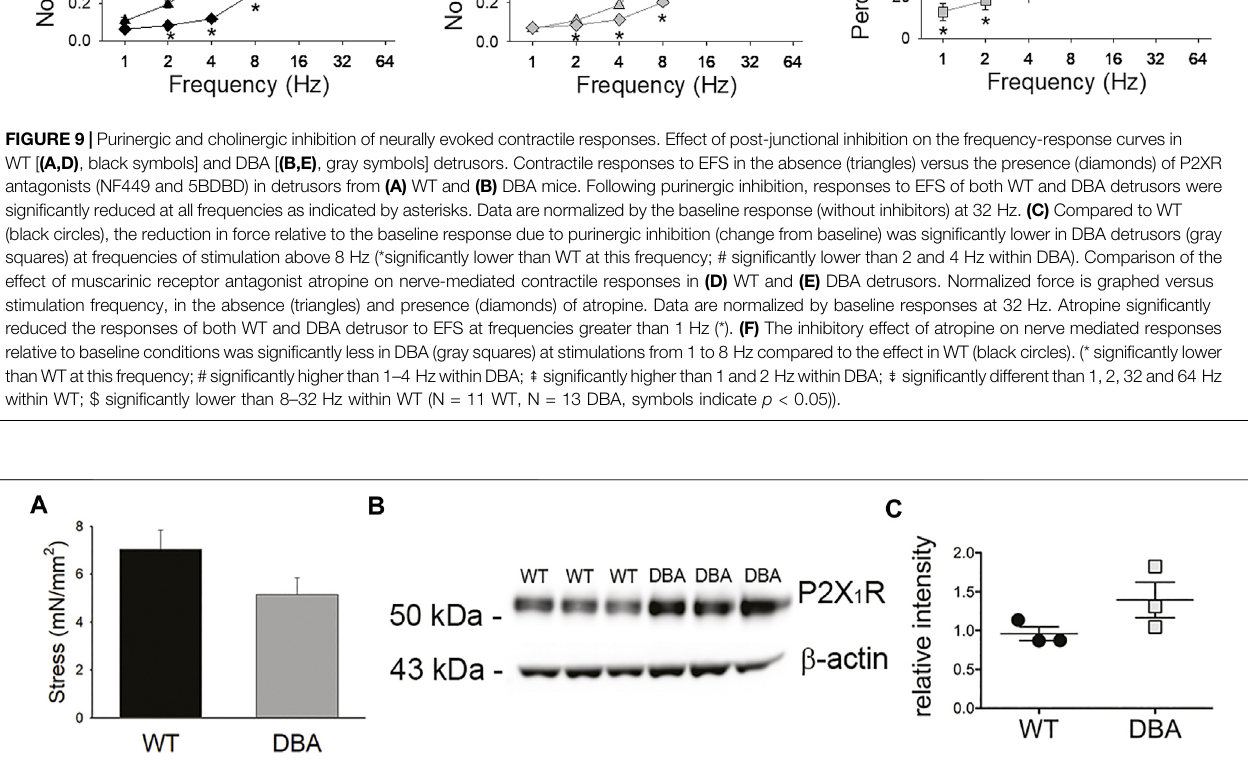
generated under baseline conditions ( p = 0.033). In contrast,